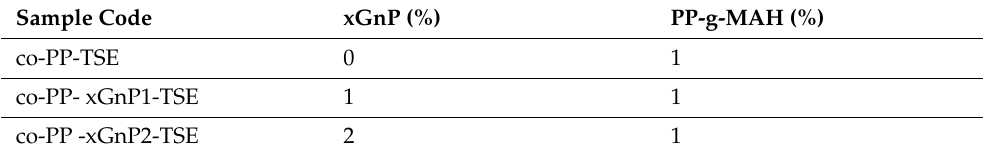
Table 2. Prepared samples by twin-screw extrusion (TSE) as Step 2 of Method 2. Sample Code